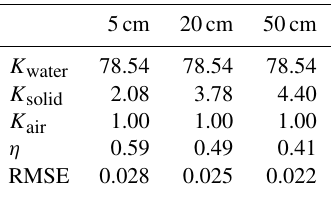
Table 1. Parameters and the RMSE of the CRIM model for 5, 20, and 50cm depth.